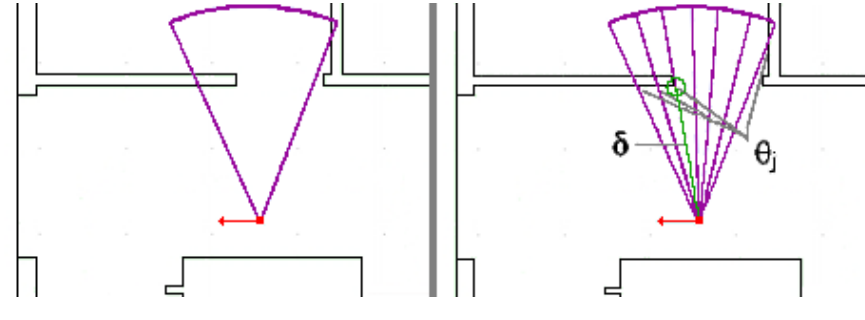
Figure 7. The rays sampling approach. The user position is marked by the square, his walking direction indicated by the arrow. The cone represents the area covered by a range sensing device ( left ). The area is sampled into rays. The circle indicates a plausible obstacle reflection, δ is the distance calculated and θ indicates ray-obstacle collisions angle ( right j